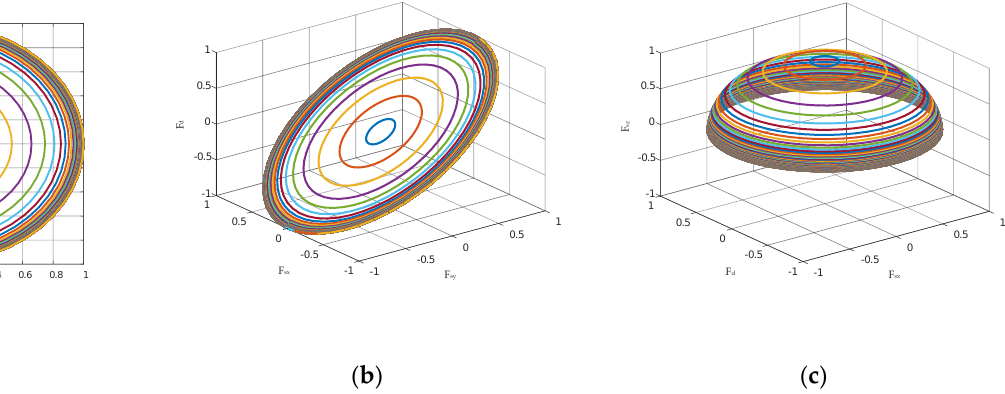
Figure 3. Clutter spectrum distribution for each distance unit. ( a ) F d -F sx ( b ) F d -F sx -F sy ( c ) F d -F sx -F sz.